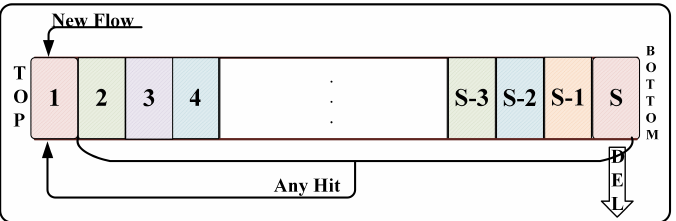
Figure 2. The LRU concept